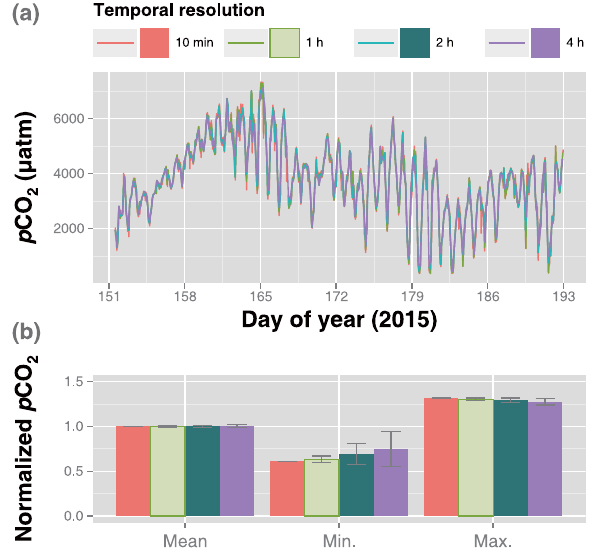
Figure 8. Temporal resolution effects on p CO 2 measurements by a membrane-enclosed sensor with a copper mesh covering. The data obtained from the copper-mesh-wrapped sensor in Fig. 6 are pre- sented by modifying temporal resolutions from 10min to 4h (a) . The bottom panel shows the daily mean, minimum, and maximum p CO 2 values normalized to the mean of the four calculations (b)